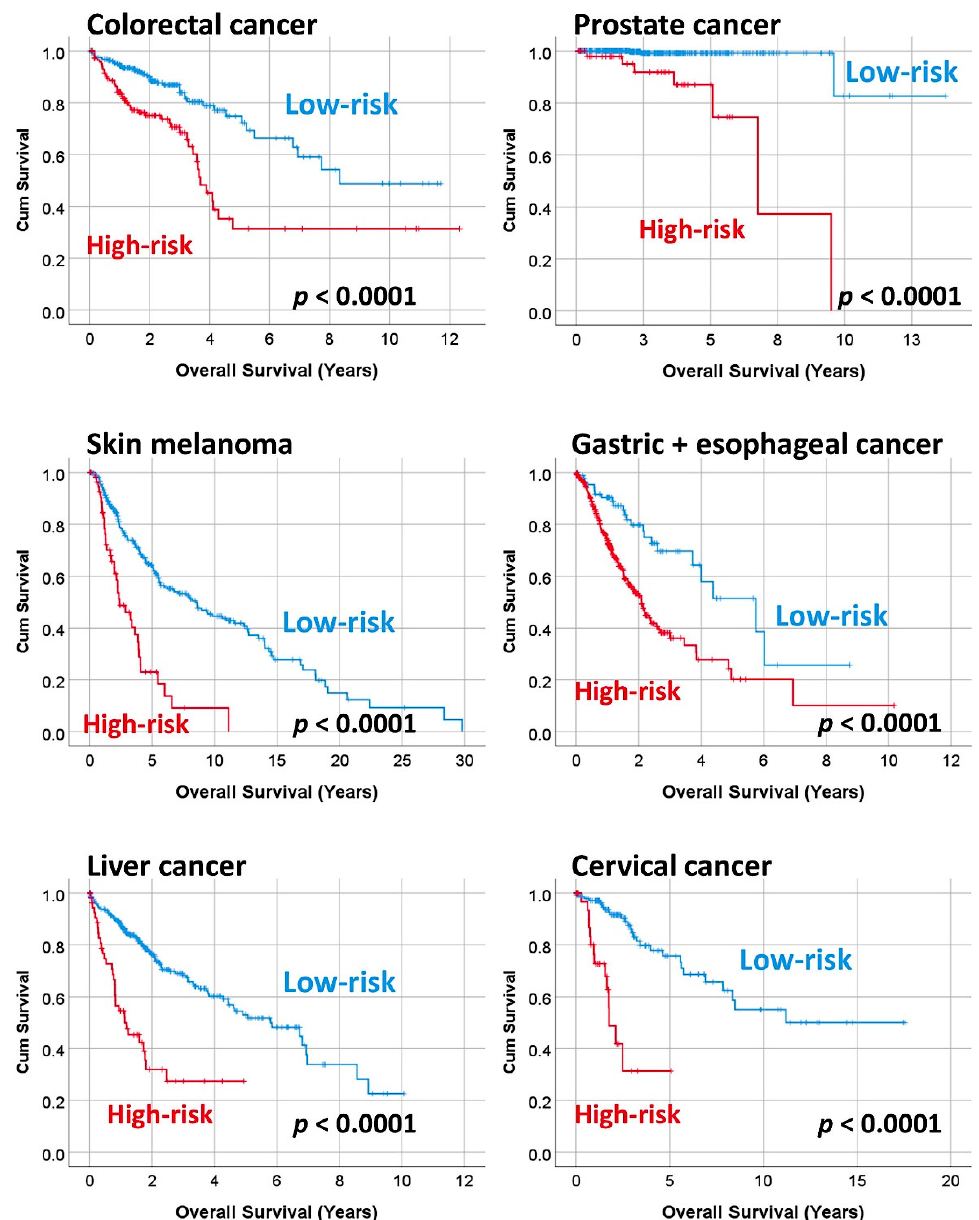
Figure 9. Predictive value for the overall survival of the top 30 genes of the MLP. Using the gene expression of 30 genes, previously identified by the MLP analysis and a risk-score formula, the overall survival of the most relevant subtypes of cancers was calculated. These prognostic genes belong to the apoptosis, cell proliferation, metabolism, and antigen presentation pathways. Colorectal cancer, Log-rank (Mantel–Cox) p -value = 2 × 10 − 6 ; prostate cancer, p = 1.6 × 10 − 11 ; skin melanoma, p = 2.5 × 10 − 10 ; gastric + esophageal cancer, p = 3.3 × 10 − 6 ; liver cancer, p = 1.4 × 10 − 10 ; cervical cancer, p = 3.7 × 10 − 9 .